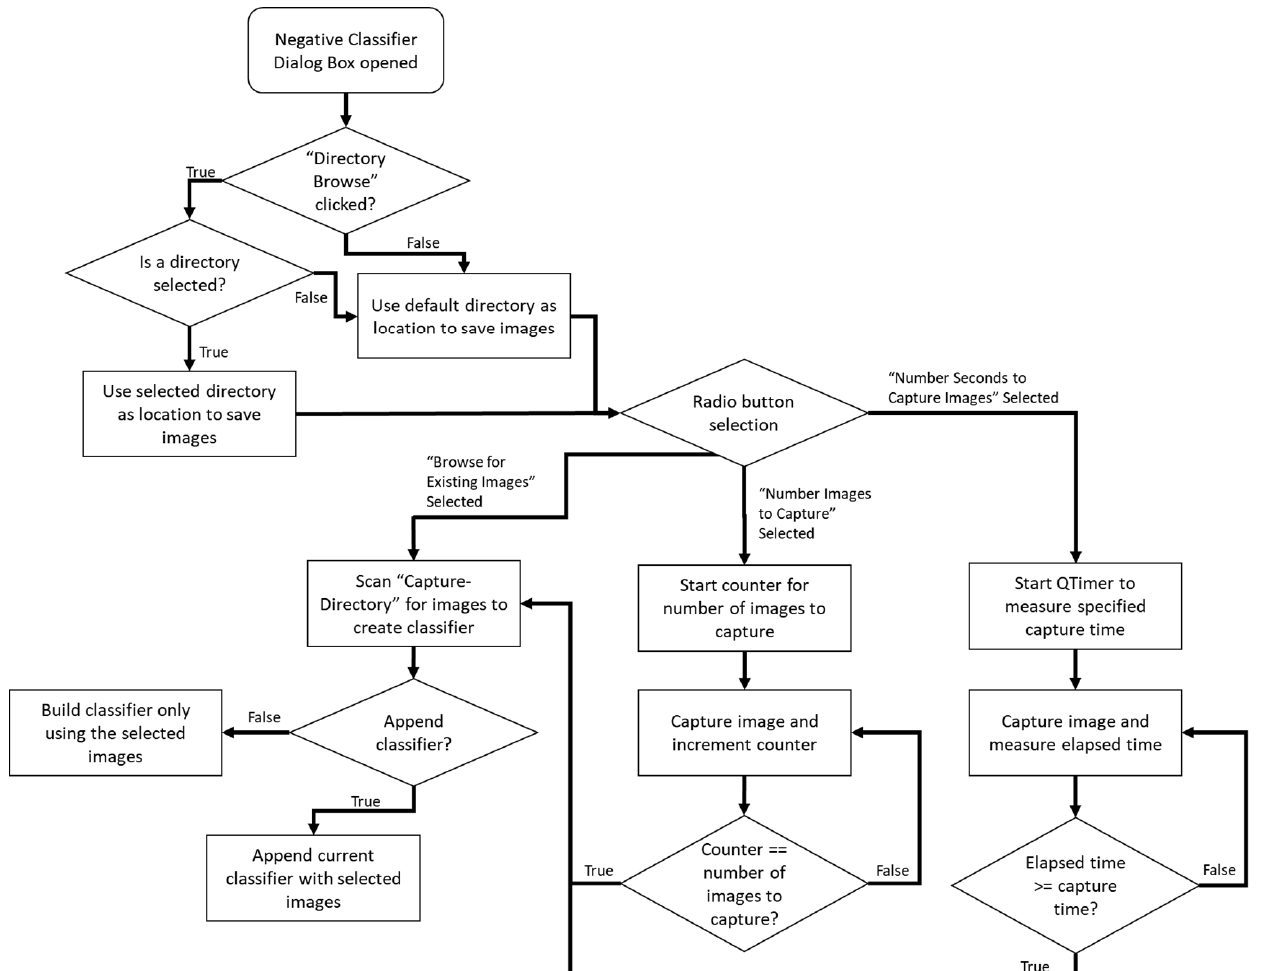
Figure 19. The negative classifier dialog box that displays when the “Build Negative Classifier” or “Append Negative Classifier” option is selected from the “Classifier” menu. The three radio buttons provide the different options for image selection.